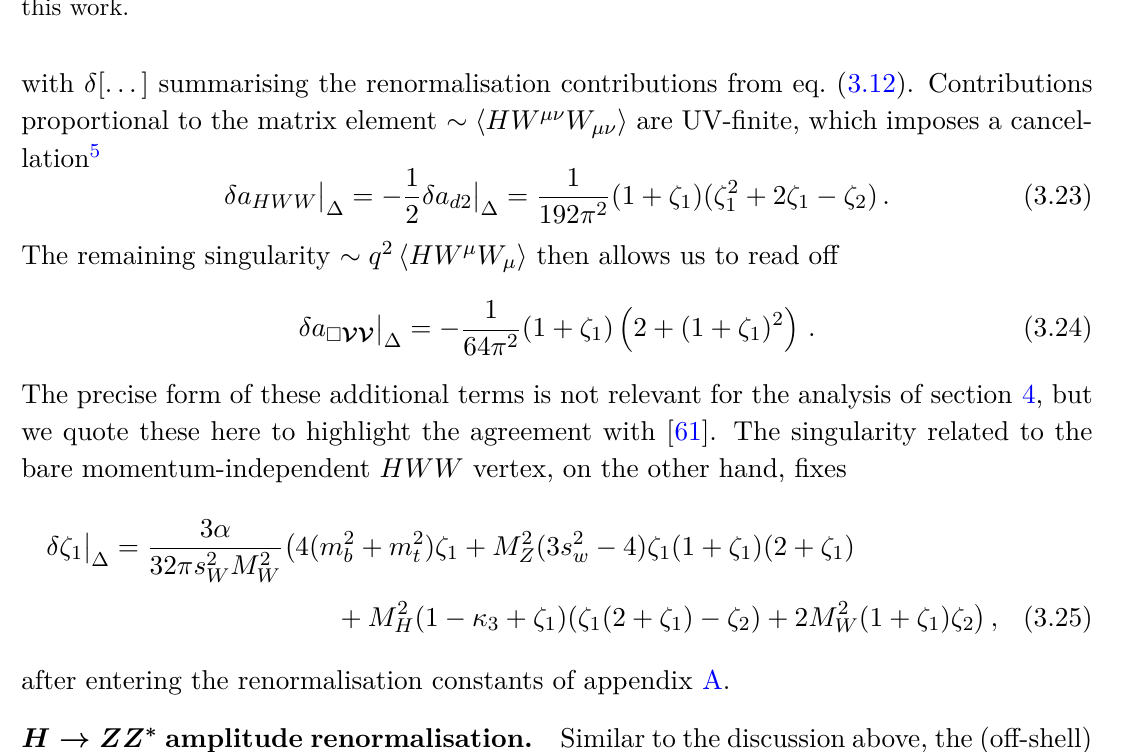
Figure 2 . Representative Feynman diagram topologies contributing to H → WW . We use abbre- viations V = { W, Z, A } for the vector bosons and G = { G 0 , G + } for the would-be Goldstone bosons. Note that we only consider the third family of fermions f = { t, b } as massive for the purpose of this